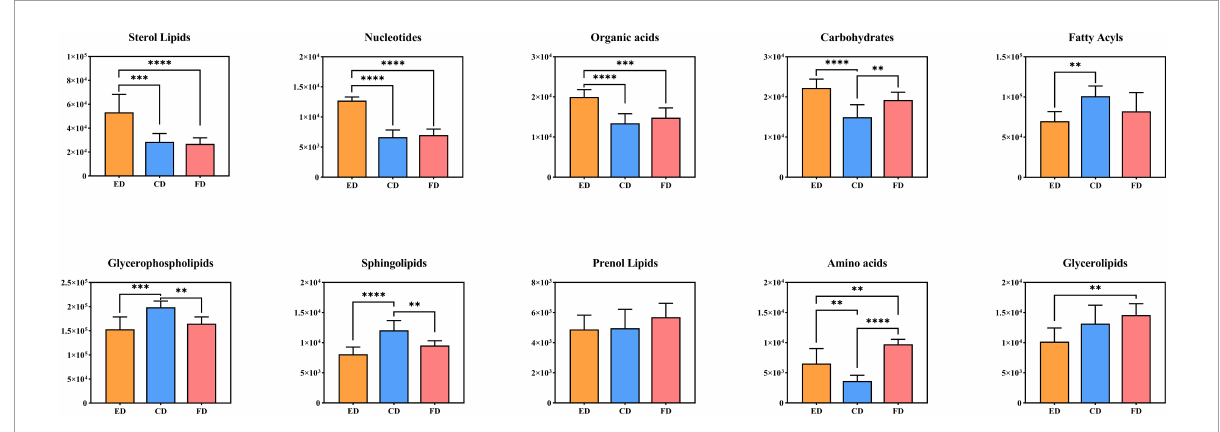
FIGURE6 Relative levels of the differential metabolite classes among the three drying methods. ∗∗ Indicates p < 0.01, ∗∗∗ indicates p < 0.001, and ∗∗∗∗ indicates p < 0.0001.